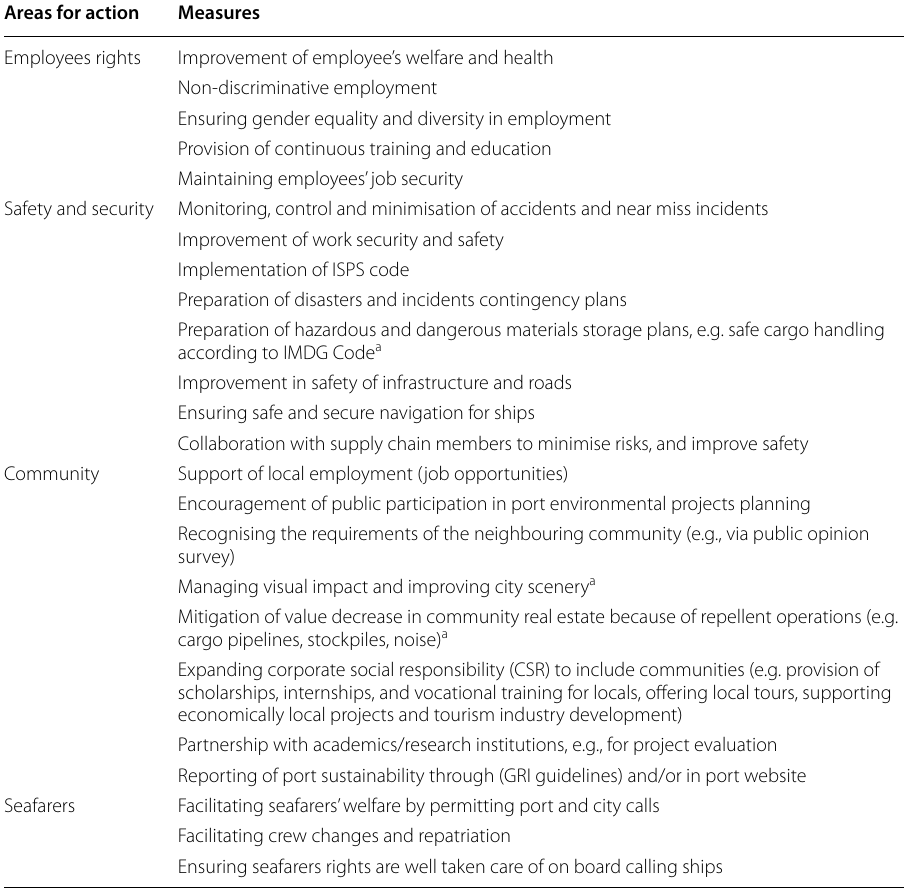
Table 6 Social dimension actions and measures. Sources : Shiau and Chuang (2013), Lu et al. (2016b), Sislian et al. (2016), Santos et al. (2016), Roh et al. (2016), Laxe et al. (2017), Oh et al. (2018), Lim et al. (2019) and IMO (2020b), IMO